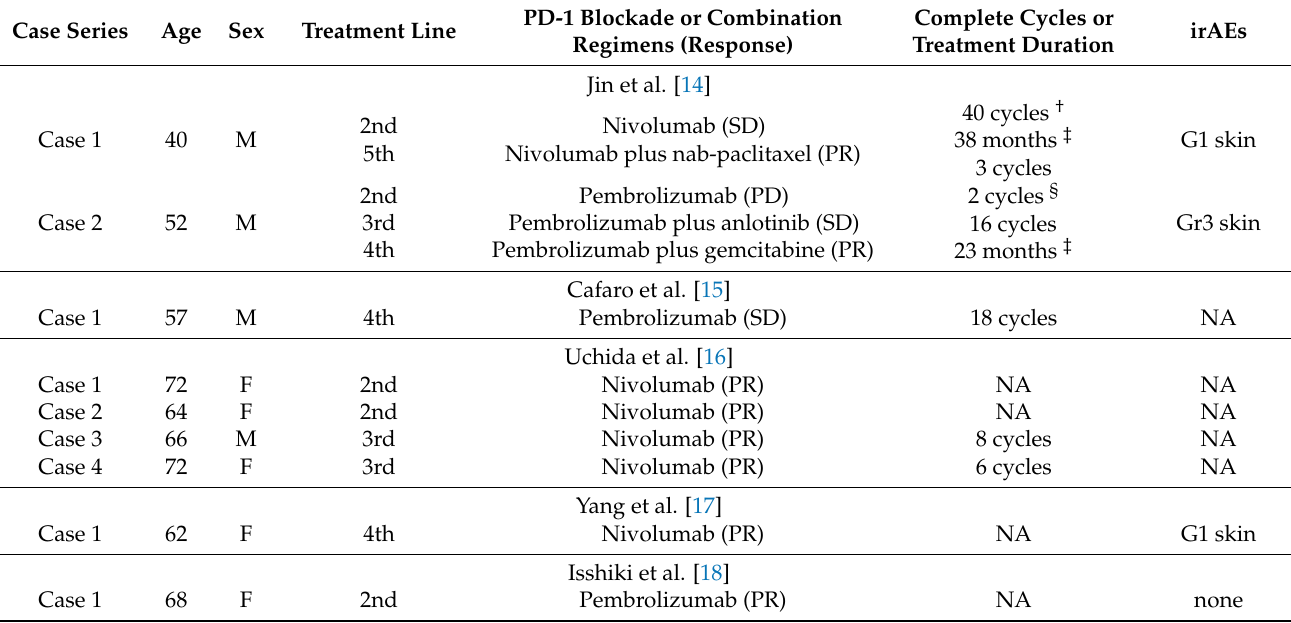
Table 3. Summary of case series regarding PD-1 blockade treatment in thymic